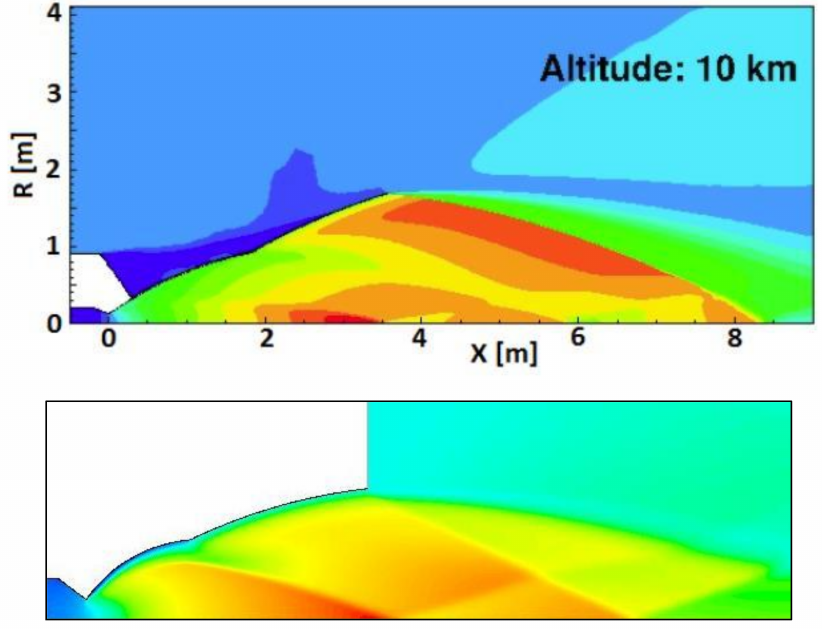
Figure 15. CFD model validations: ( top ) literature baseline compared against ( bottom ) dual bell optimised nozzle results obtained in this